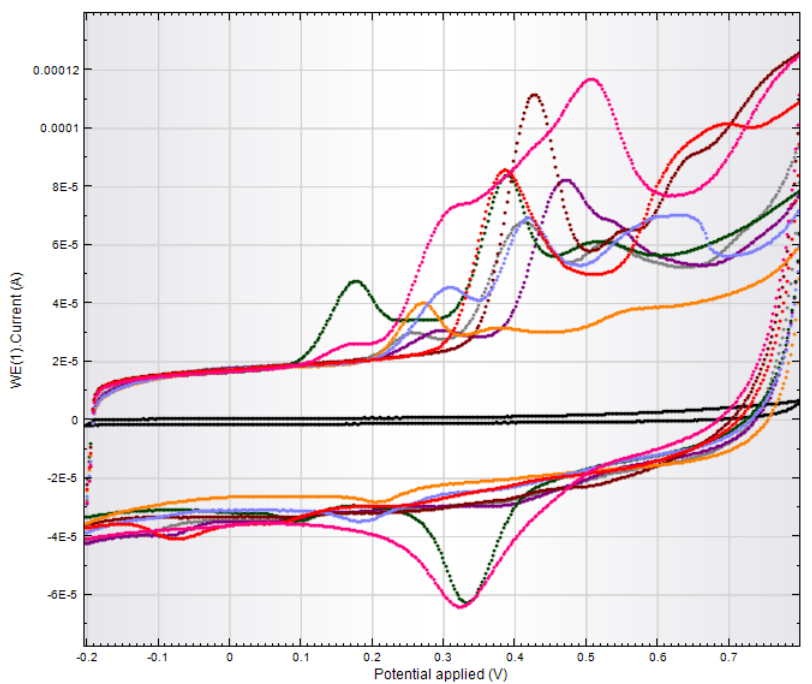
Figure 3. Overlapped CVs for solutions of the novel synthesized compounds: 5a —red; 6a —light blue; 7a —orange; 8a —green; 5b —brown; 6b —purple; 7b —gray; 8b —pink prepared in 0.1 M HClO 4 on graphite-based SPE. Black line: CV recorded in 0.1 M HClO 4 .